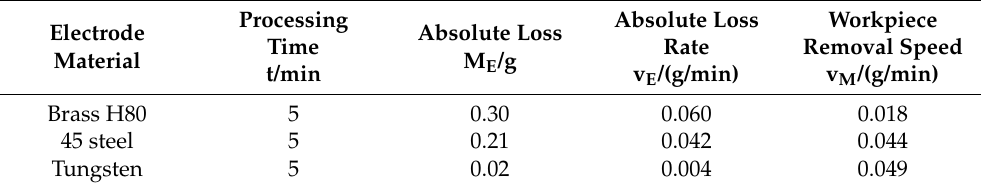
Table 4. Comparison of relative mass loss of